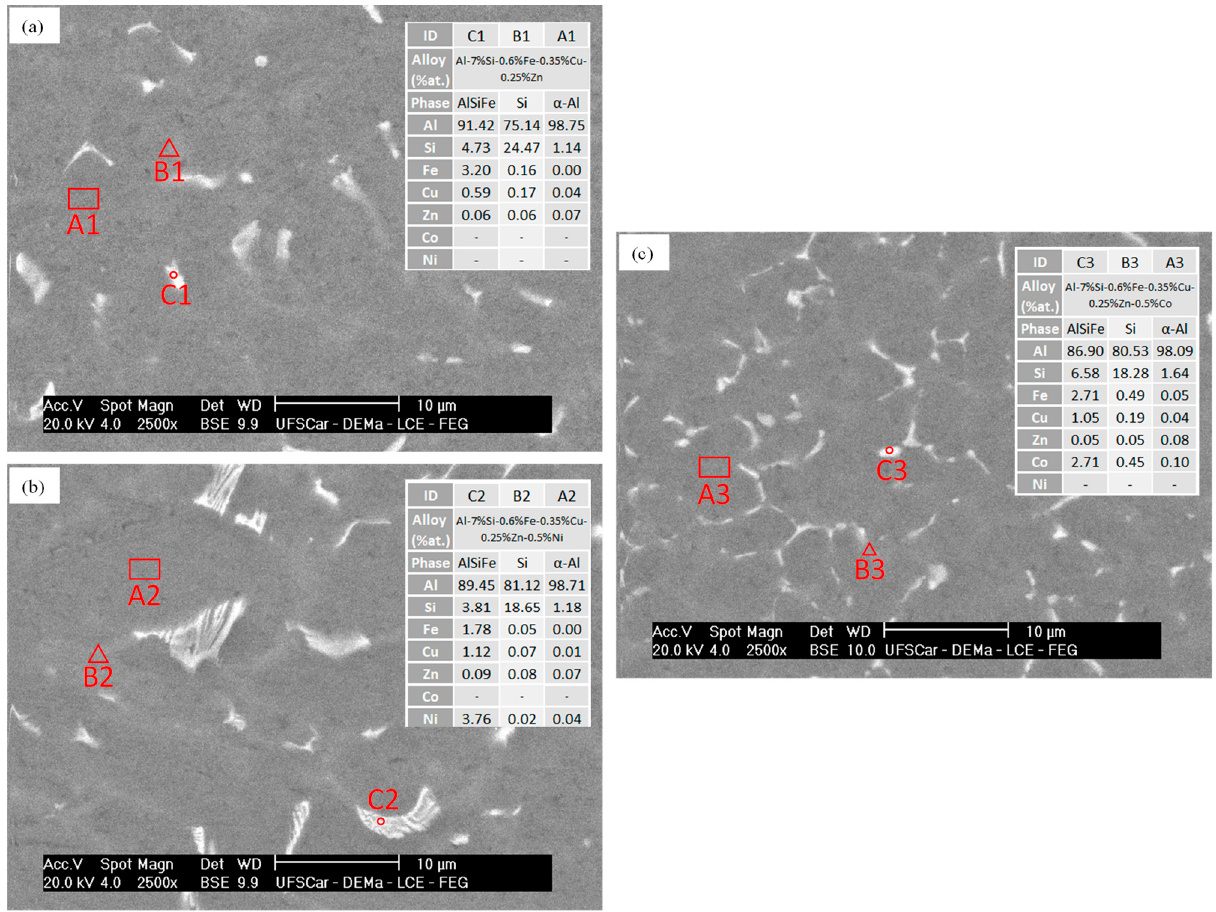
Figure 3. Typical SEM microstructures and EDS analyses for: ( a ) Al-7%Si-0.6%Fe-0.35%Cu-0.25%Zn, ( b ) Al-7%Si-0.6%Fe-0.35%Cu-0.25%Zn-0.5%Ni and ( c ) Al-7%Si-0.6%Fe-0.35%Cu-0.25%Zn-0.5%Co alloys.